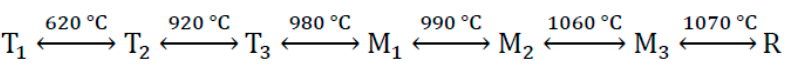
Figure 1. The sequence of alite transformations.